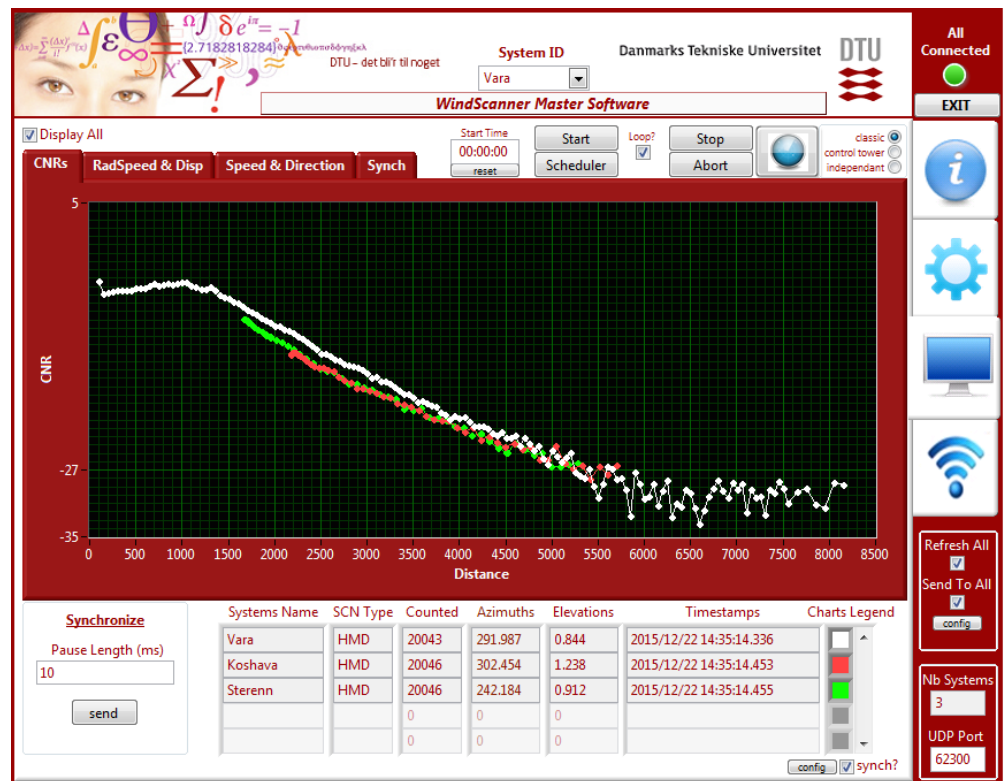
Figure 7. The master computer software